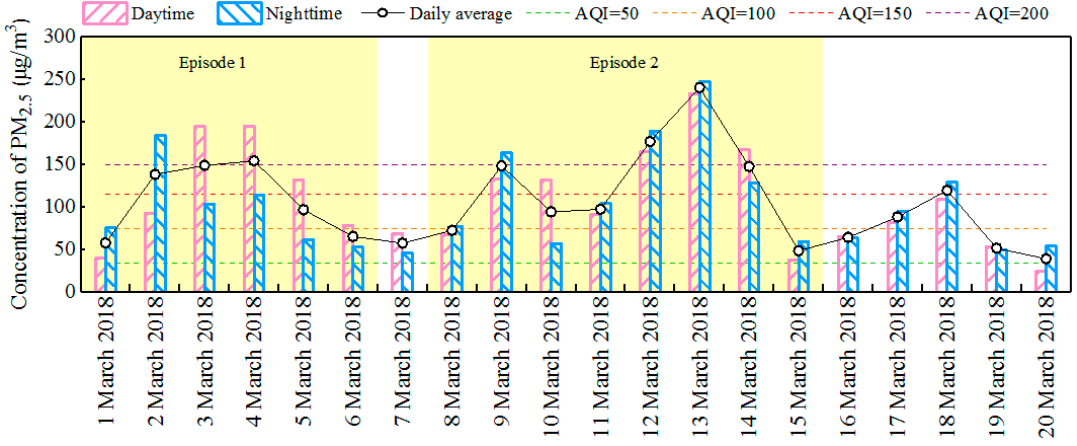
Figure 3. Daily and diurnal variation of PM 2.5 mass concentrations in the study area during the monitoring period.